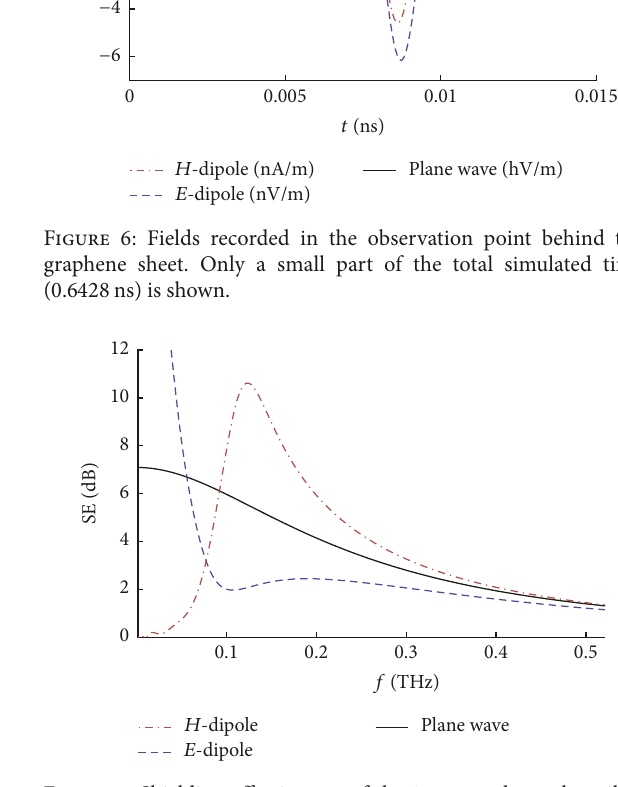
Figure 7: Shielding effectiveness of the 1 nm graphene sheet illu- minated by a small 𝐸 - and 𝐻